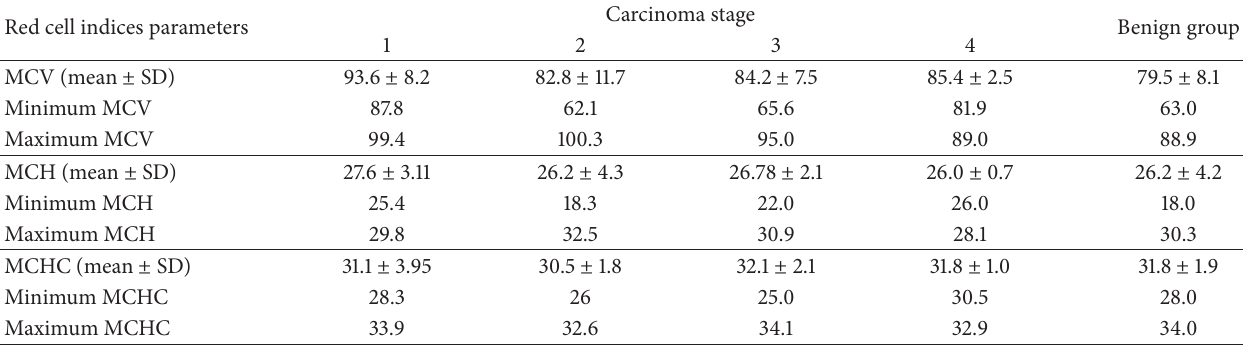
Table 3: Red cell indices in relation to four stages of carcinoma and benign group.